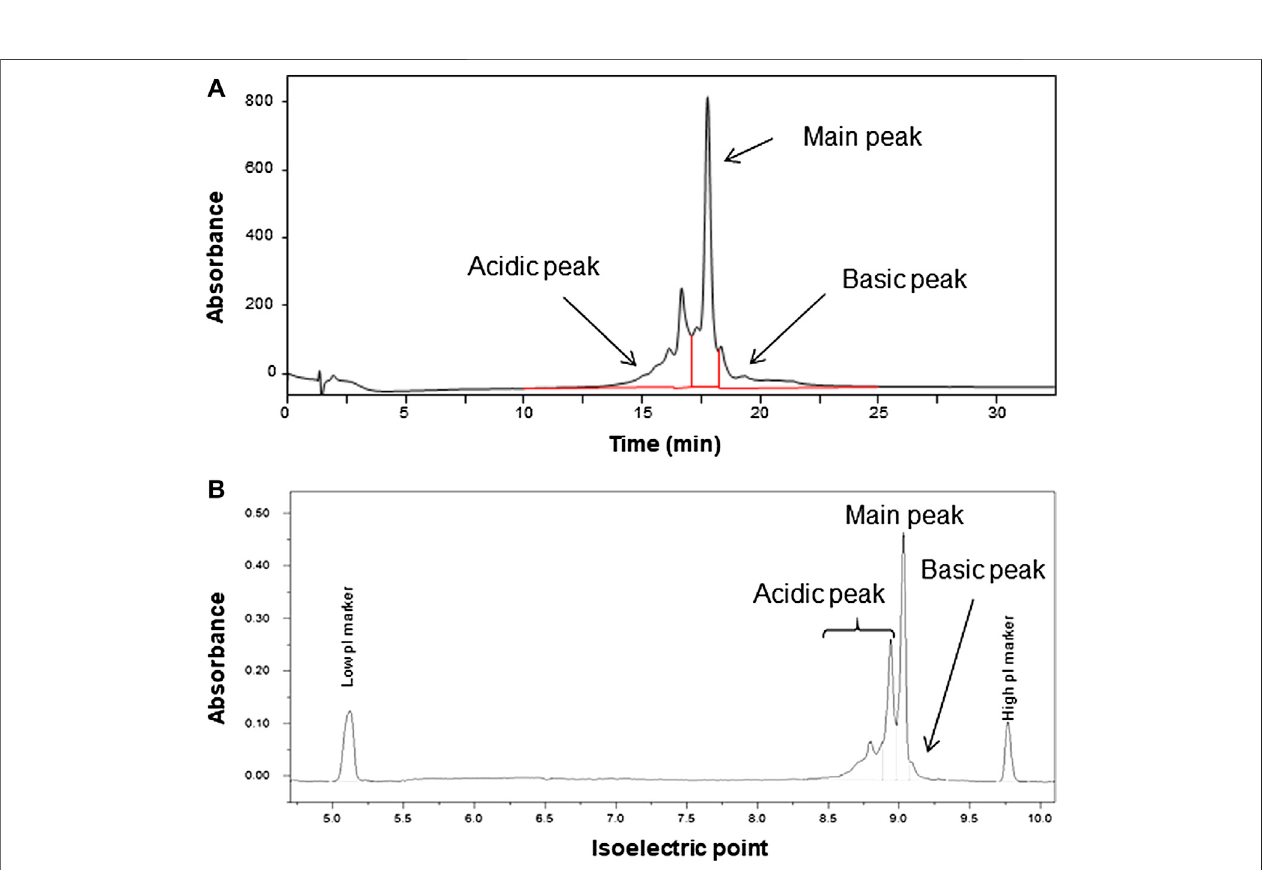
Frontiers in Molecular Biosciences |